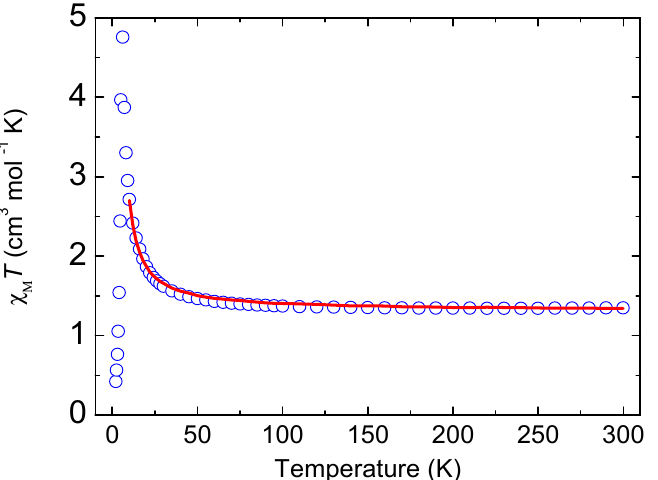
Figure 4. The temperature dependence of χ M T for compound 1 at temperatures between 2 to 300 K with a 1 kOe applied field. The solid line shows the best fit of the data mentioned in the text.